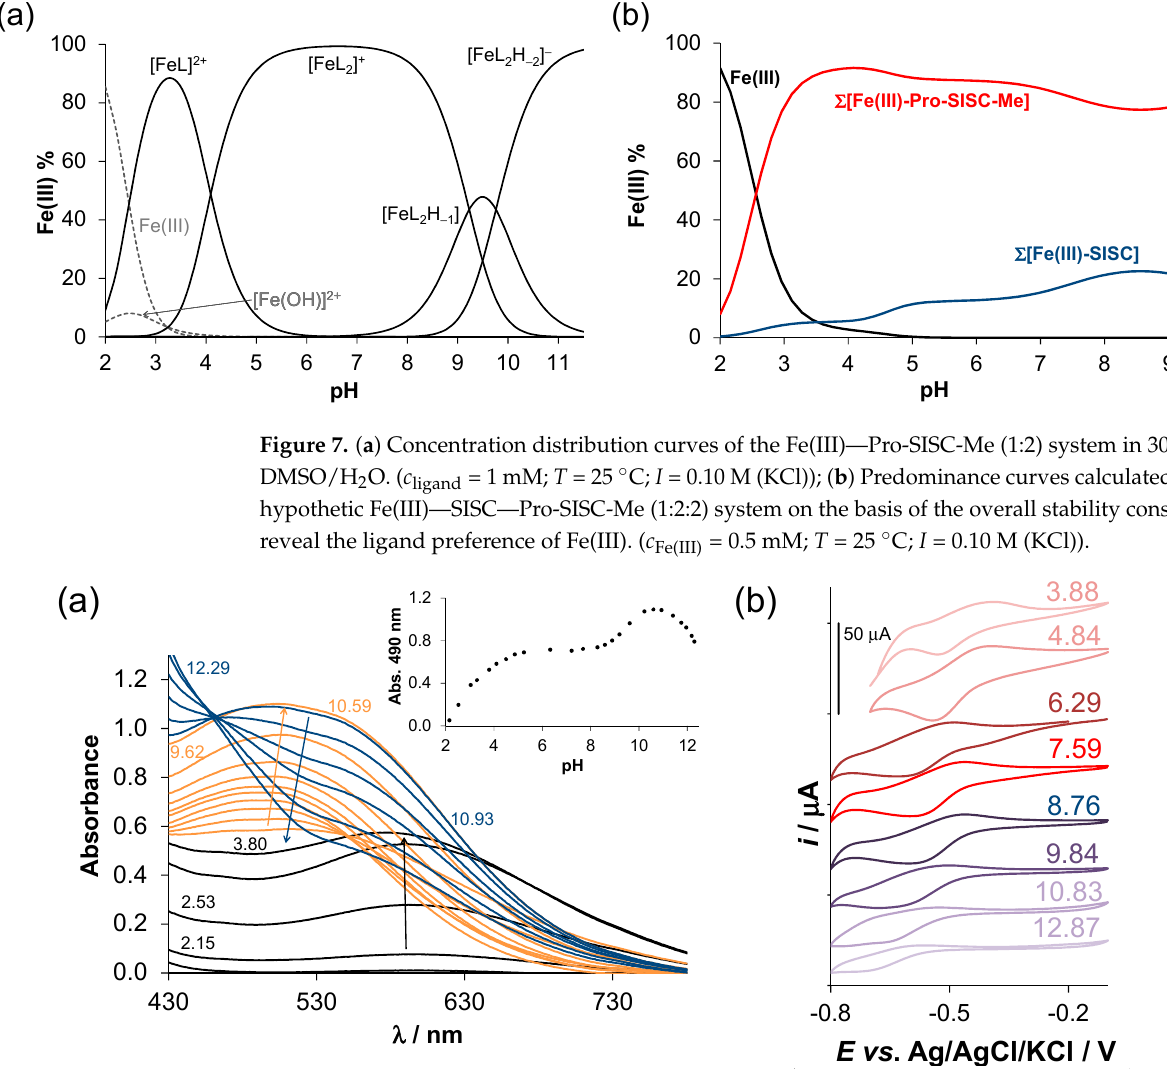
Figure 8. ( a ) UV-vis spectra recorded for the Fe(III)—Pro-SISC-Me (1:2) system in 30% ( v / v ) DMSO/H 2 O at various pH values (indicated in the figure). ( c ligand = 1 mM; T = 25 °C; I = 0.10 M (KCl); ℓ = 1 cm); ( b ) Cyclic voltammograms for the iron complexes of Pro-SISC-Me at 1:2 metal-to-ligand ratio at various pH values in 30% ( v / v ) DMSO/H 2 O. ( c ligand = 1 mM; T = 25 °C; I = 0.10 M (TBAN); scan rate: 20 mV/s).